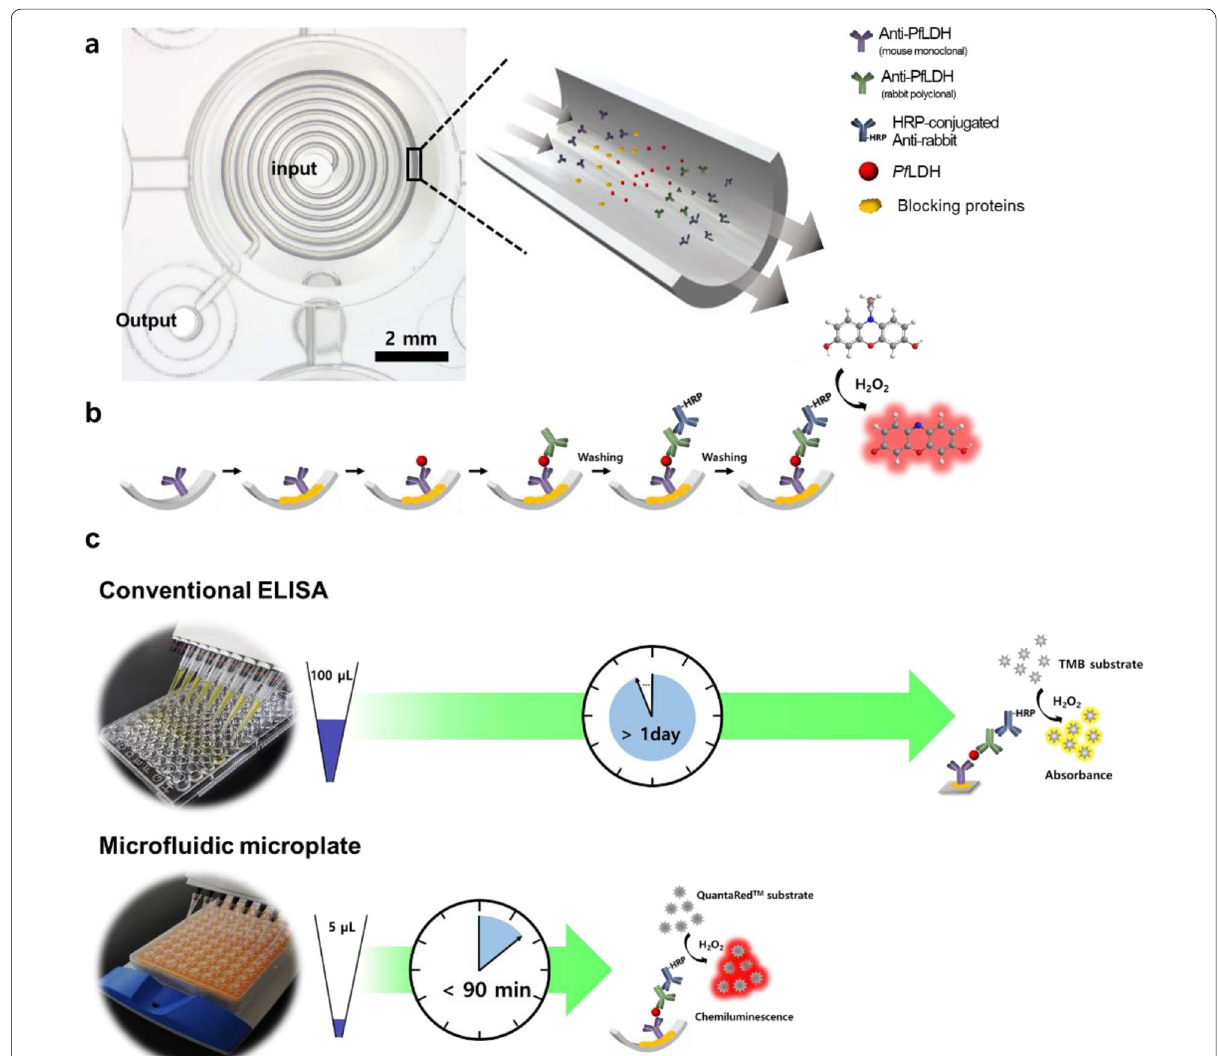
Fig. 1 Schematic illustration for diagnosis of Pf LDH using microfluidic microplate. a Optical image of the microfluidic microplate. The microfluidic microplate allows for low volume and rapid immunoassay due to microfluidic channel. b Flow sequence for detection of Pf LDH. c Comparison of Pf LDH detection method using conventional ELISA and microfluidic